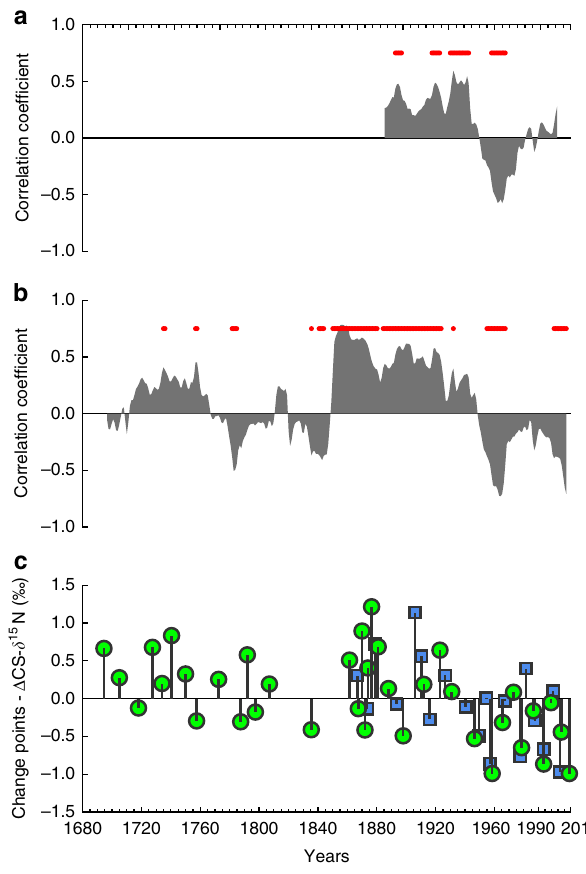
Fig. 3 Coral skeleton CS- δ 15 N and Burdekin River fl ow correlation plots. a Correlation coef fi cients for a moving correlation (30-year window) between the annual Pandora Reef CS- δ 15 N record and Burdekin River fl ow. Red dots show signi fi cance at the 95% level. b Correlation coef fi cients for a moving correlation (30-year window) between the annual Havannah Island CS- δ 15 N record and Burdekin River fl ow. Red dots show signi fi cance at the 95% level. c Change points for Pandora Reef (green) and Havannah Island (blue) composite CS- δ 15 N records. Change point values are normalised to the overall mean CS- δ 15 N of each